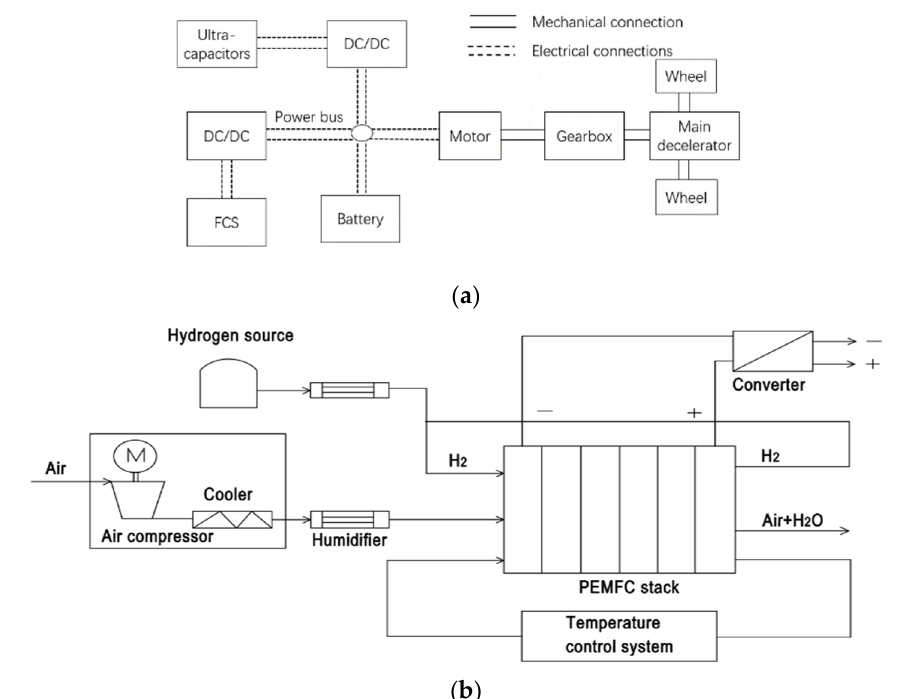
Figure 1. Structure of power system of FCEVs and an FCS: ( a ) Power system structure ( b ) FCS structure.